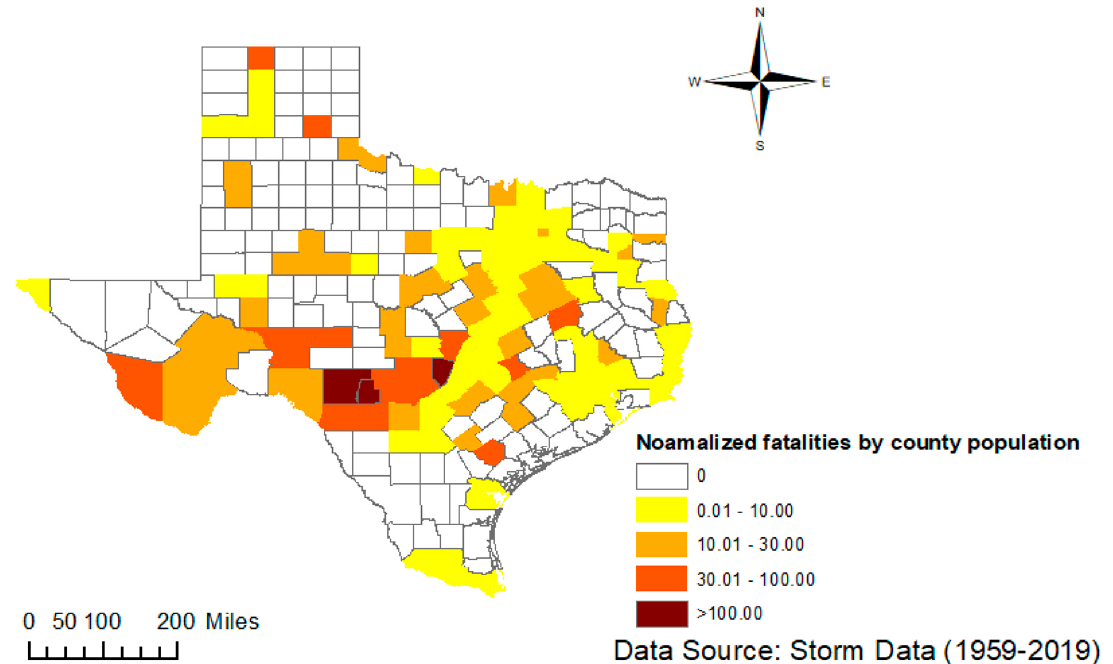
Figure 10. Normalized vehicle-related flood fatalities by county in Texas (per 100,000 residents), 1959–2019.